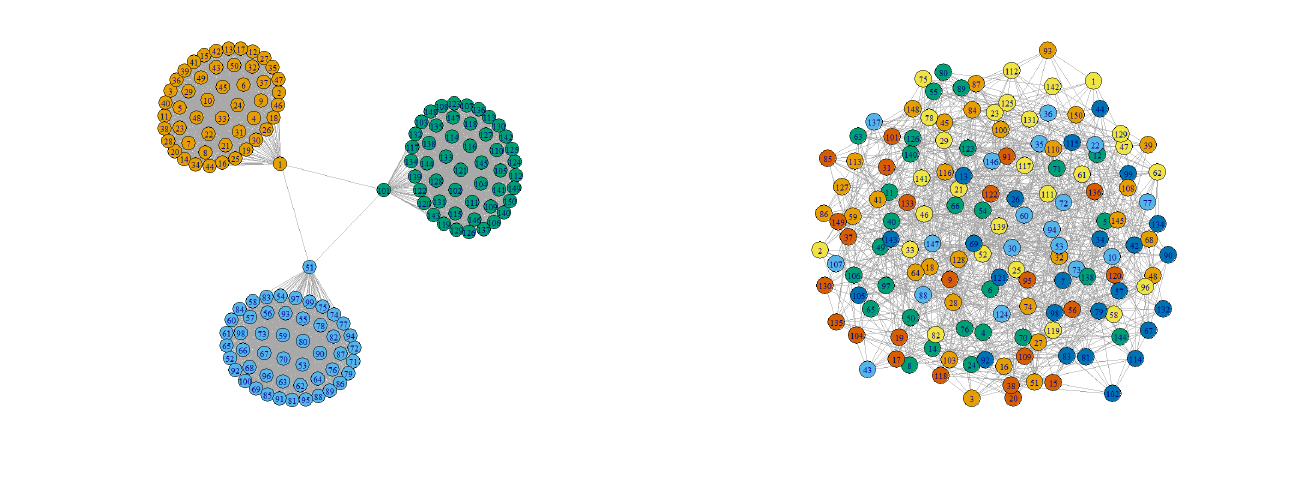
Figure 10. Community detection of the weighted network for the first and the second company using the Louvain algorithm. Next, assume that each group or community or subgraph is mutually exclusive.